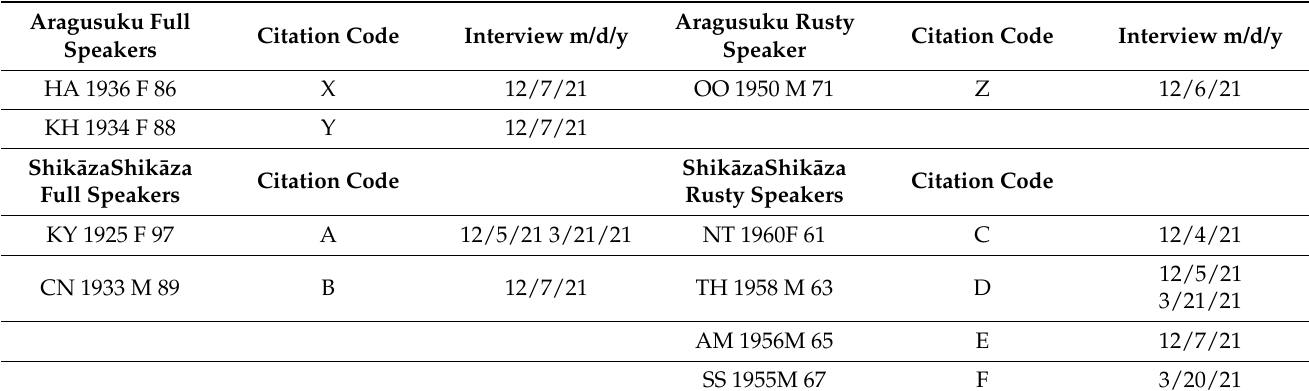
Table 2. Collaborators to this study (initials, birthyear, gender, age as of February